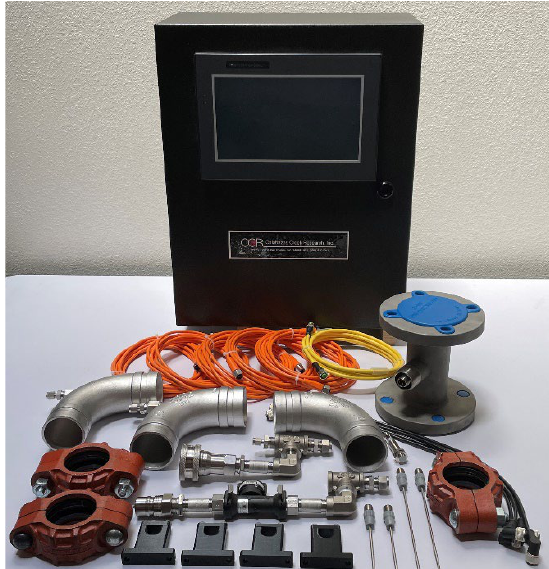
Fig. 15. Diagnostic and control system, including PLC controller, plumbing, and sensors